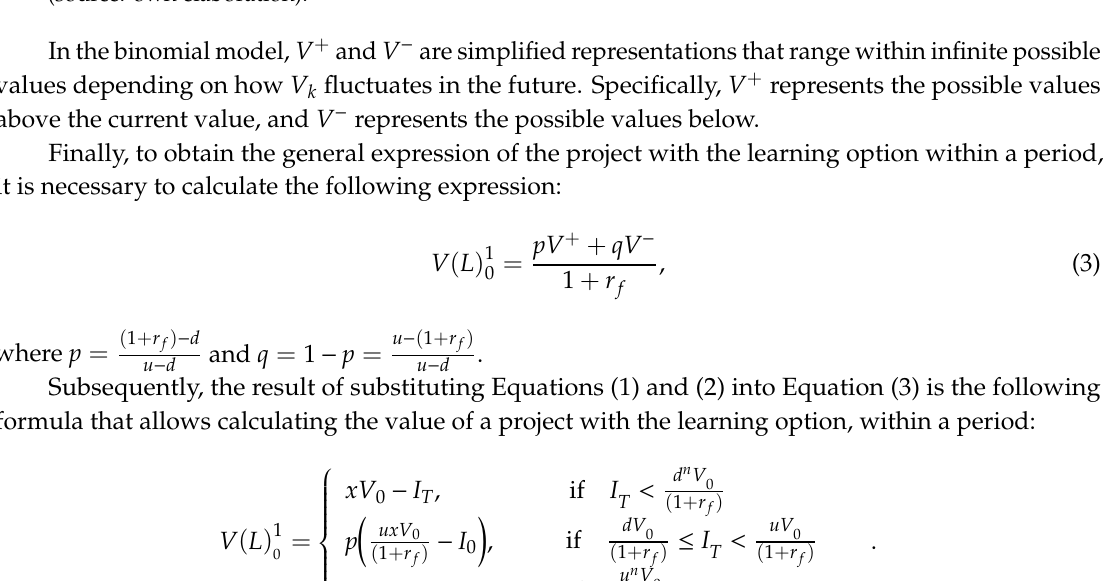
Figure 1. Evolution of the future cash flow from period k to period k + 1 using the binomial model (source: own elaboration).